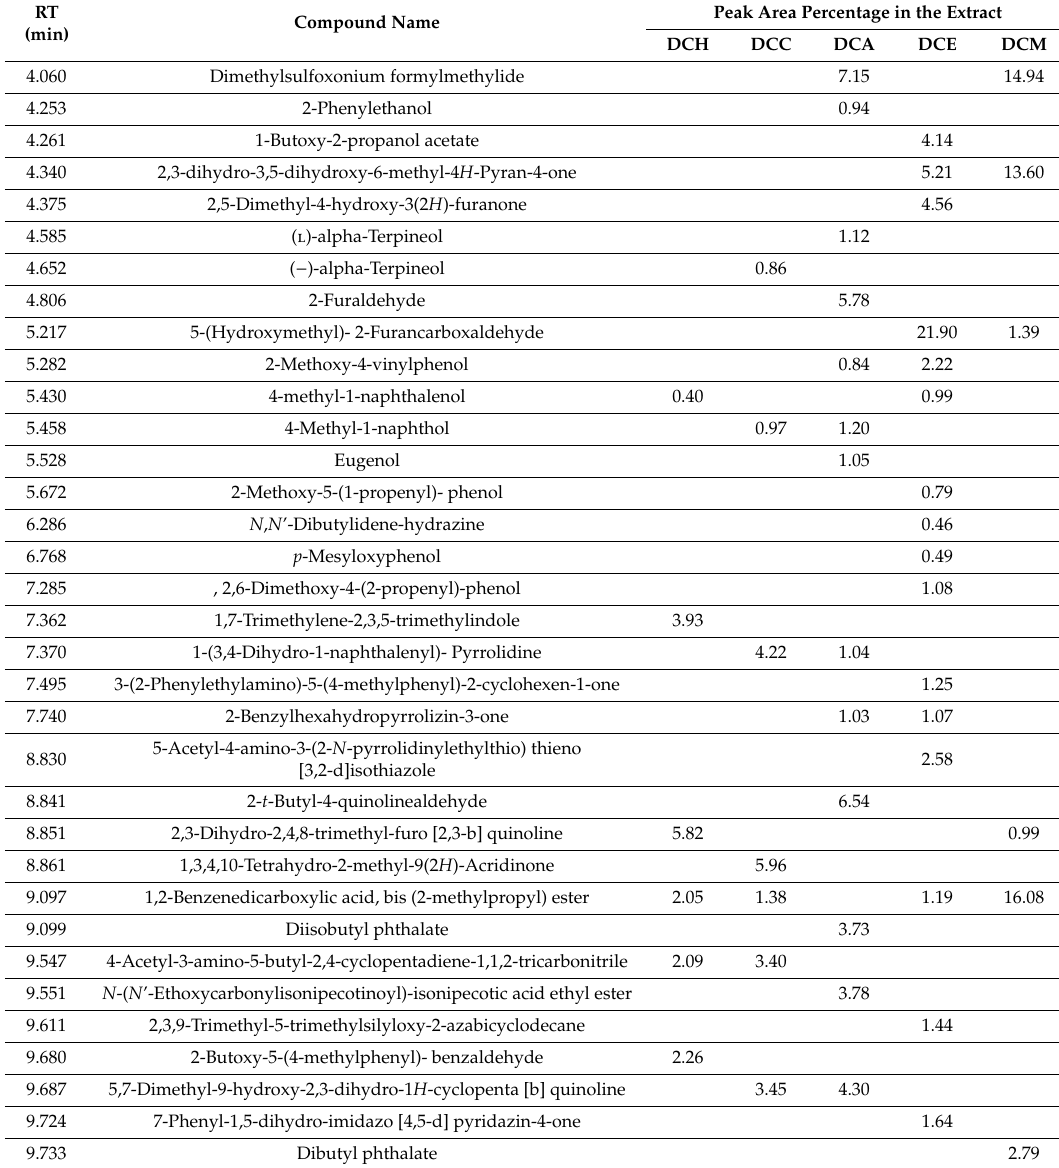
Table 7. Identified compounds from the extracts of D. crepidatum by GC–MS. RT—retention